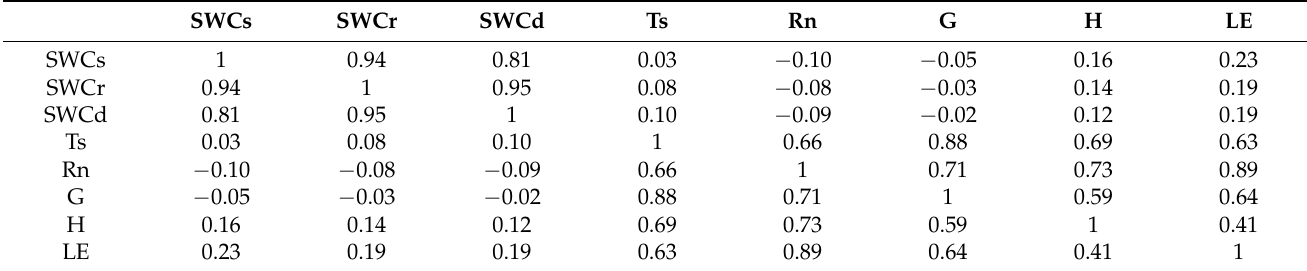
Table 7. Correlation coefficient of HELP model state variables and surface flux in wheat season.